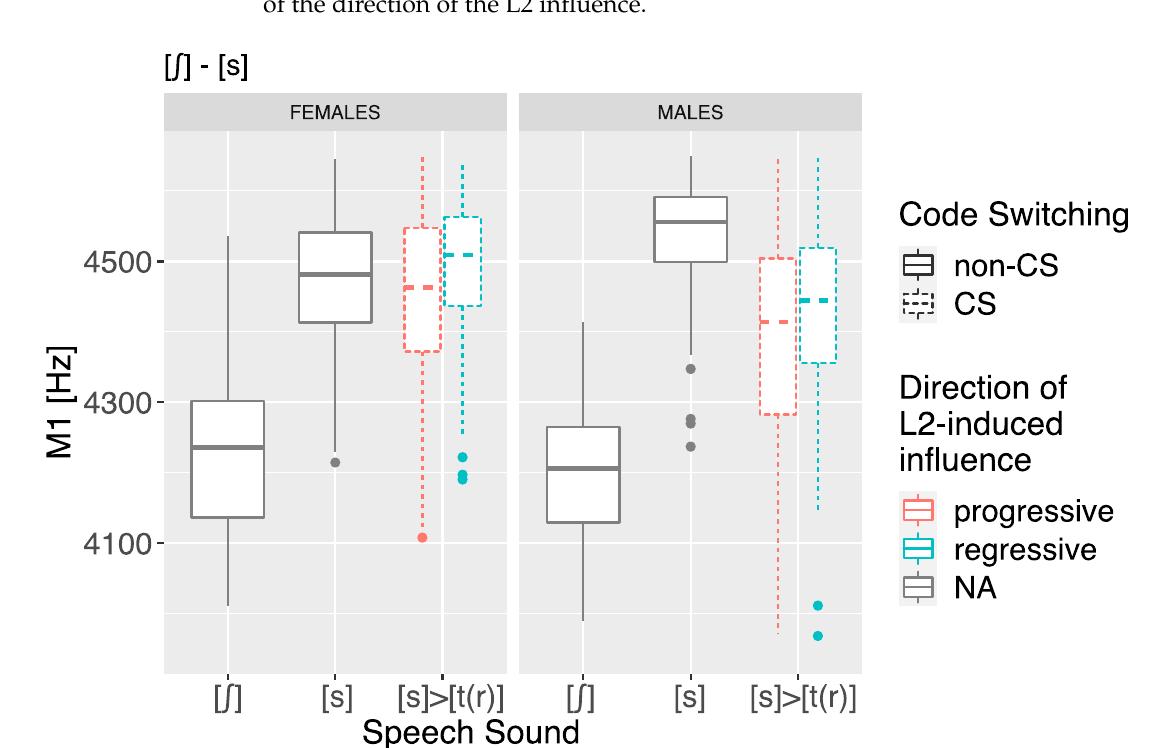
Figure 7. The first spectral moment of intended [ ʃ ] and [s] sounds in English words, spoken by BIL speakers in non-CS (solid) and CS (dashed) speech; productions in CS environments are divided into progressive (red) and regressive (blue) L2-induced influences. The left panel shows female data, the right panel male data.